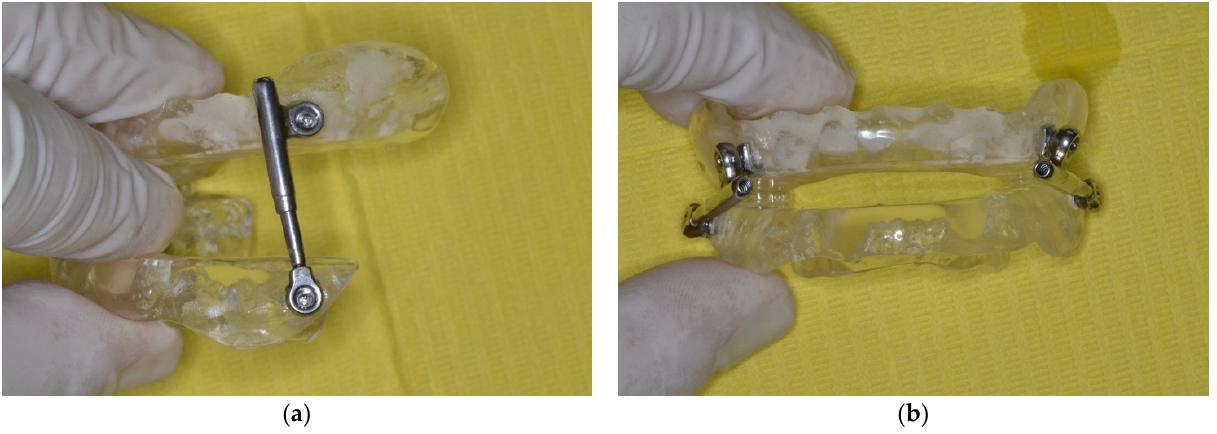
Figure 5. ( a , b ) The Class III PowerScope appliance with two fixed acrylic splints and a telescopic mechanism with a Ni–Ti internal spring